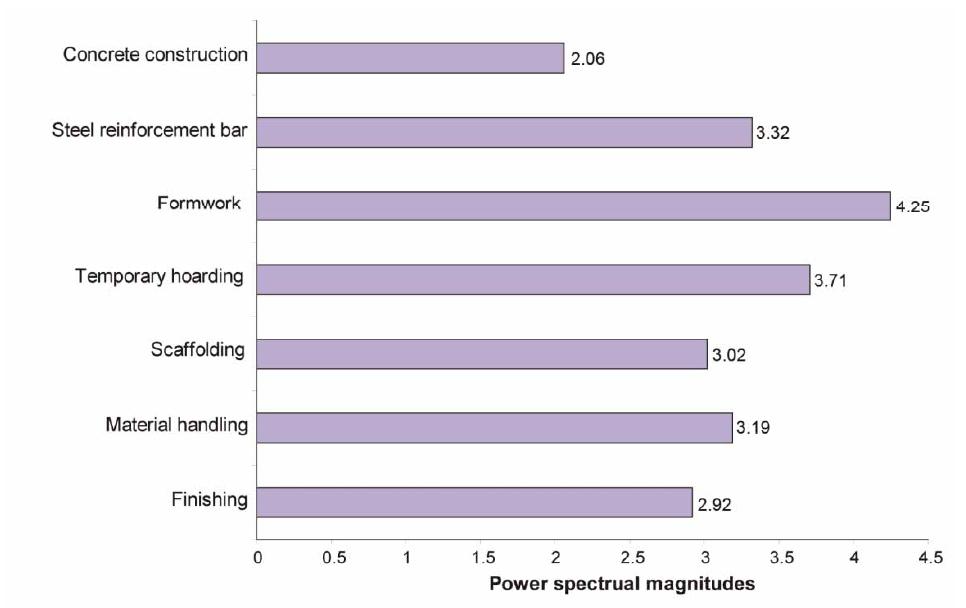
Fig. 1. Major sources of construction waste